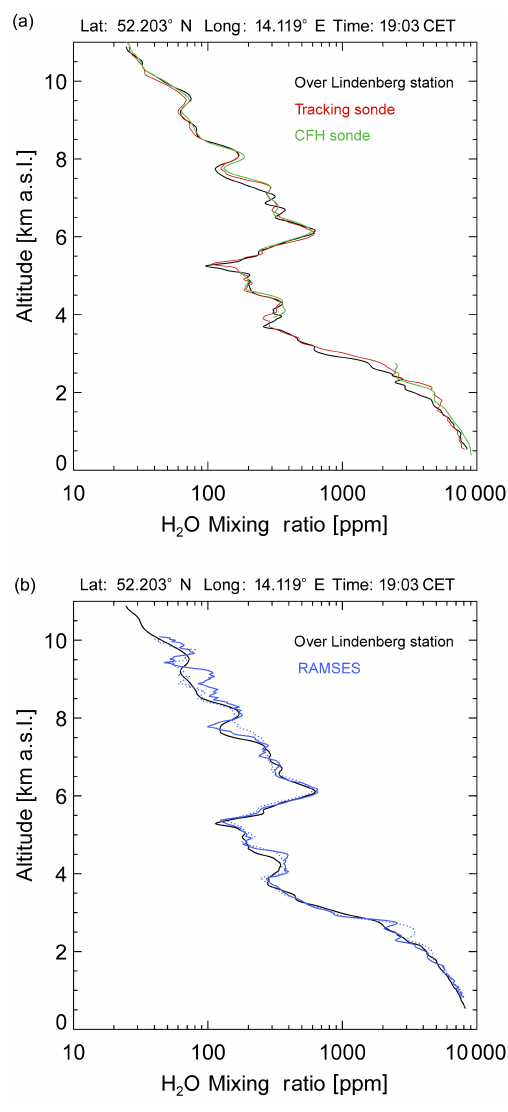
Figure A2. (a) Comparison of WALES, a RS92 and a CFH sonde over Lindenberg (Germany); the launch time of the balloon was 18:44CET. The time given above the panel is that of the passage of the aircraft above the station. The WALES profile was evalu- ated slightly delayed for matching the average balloon position. (b) Comparison of the WALES an RAMSES lidar systems over Lin- denberg (Germany); Lindenberg; for RAMSES two data accumula- tion times were taken, 10min (blue line, central time 18:57CET) and 30min (broken blue line, central time 18:47CET).